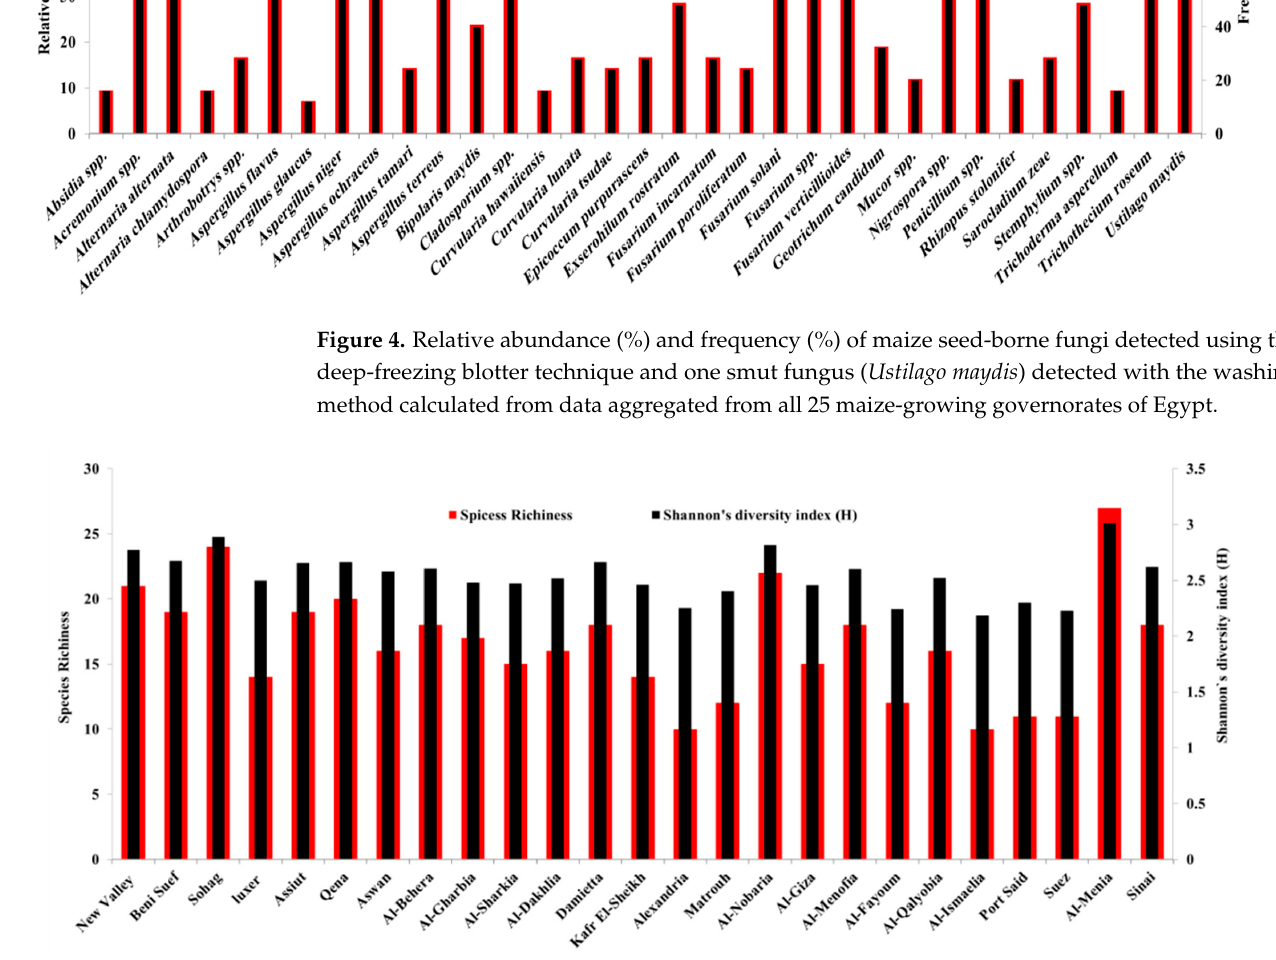
Figure 5. Species richness (total number of fungus species identified) and species diversity (the Shannon-Wiener diversity index) calculated from the seed-borne fungi recovered from maize grain samples in each of the 25 maize-cropping governorates in Egypt.